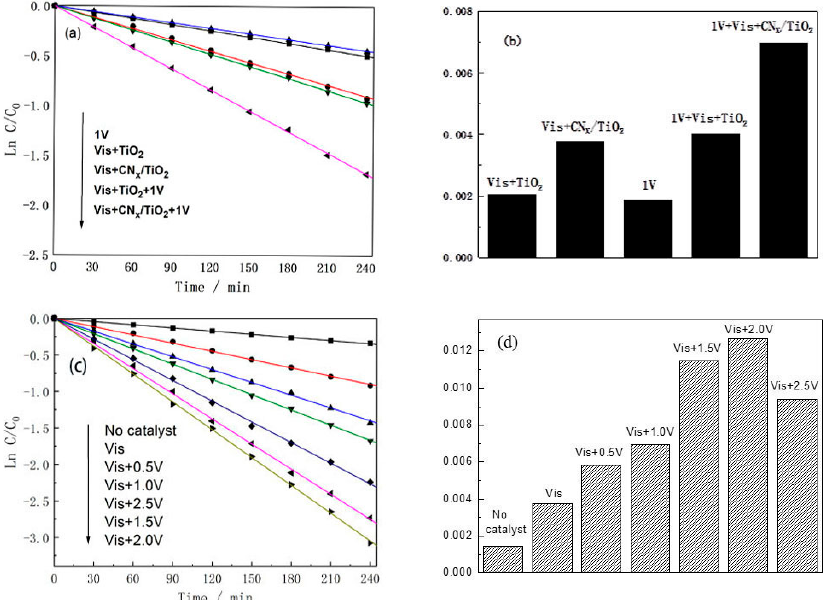
Figure 5. ( a , b ) Comparison of EC and PEC degradation rate of MB with CN x /TiO 2 and TiO 2 . ( c , d ) Comparison of PC and PEC degradation rate of MB with CN x /TiO 2 core-shell nanowire arrays by different bias voltage under visible light ( λ ≥ 420 nm).